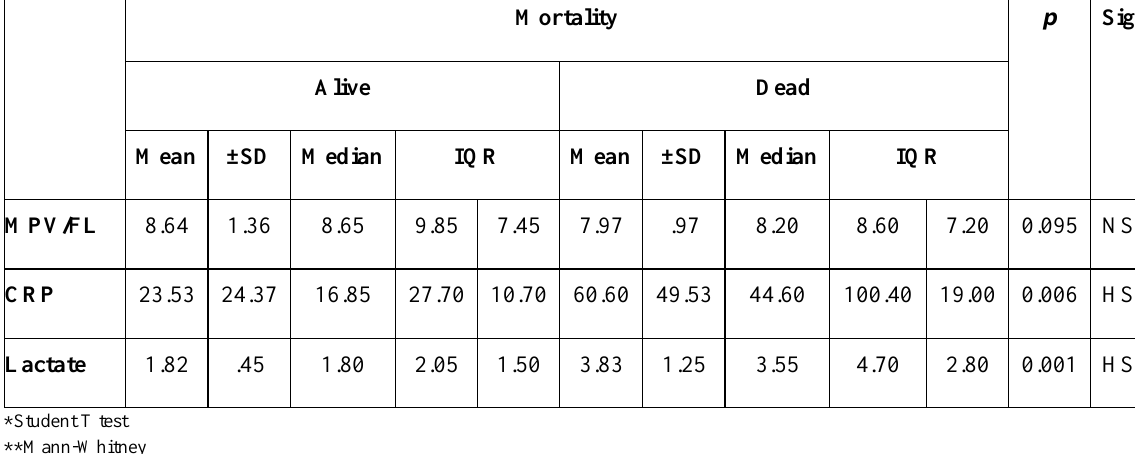
Table 4. Comparison between survived, and non-survived controls as regards laboratory data.